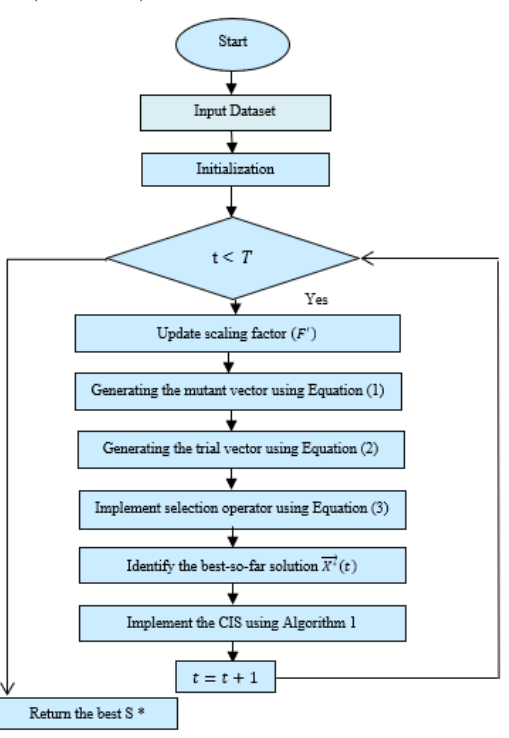
Figure 3. The flowchart of the proposed algorithm: HDE (* is used to identify the best solution).